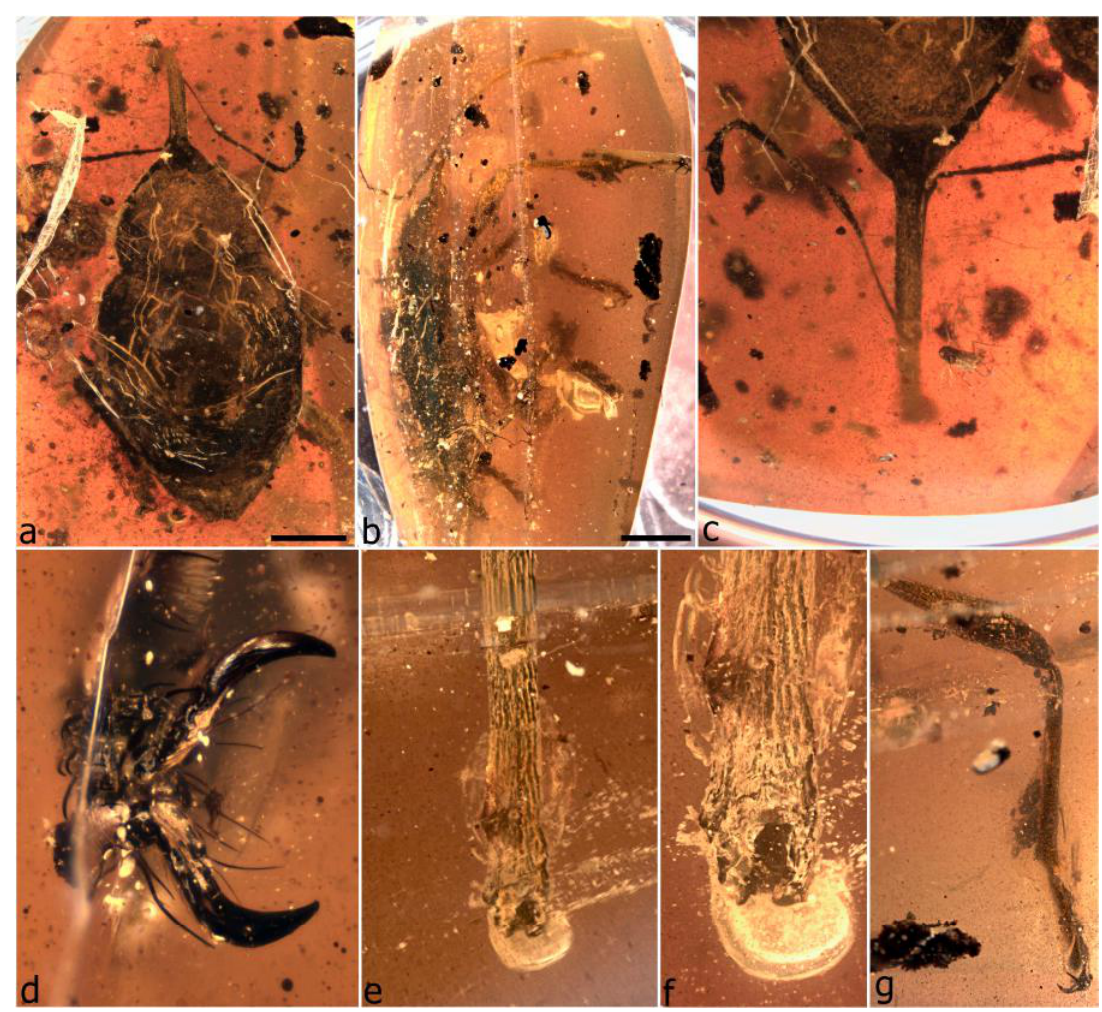
Figure 33. Cetionyx ursinus sp. n., holotype. Habitus, dorsal ( a ); habitus, right lateral ( b ); head and antennae, dorsal ( c ); protarsal claws ( d ); apical part of rostrum, dorsal ( e ); mandibles ( f ); right anterior leg ( g ). Scale bars: 2.0 mm (a,b).